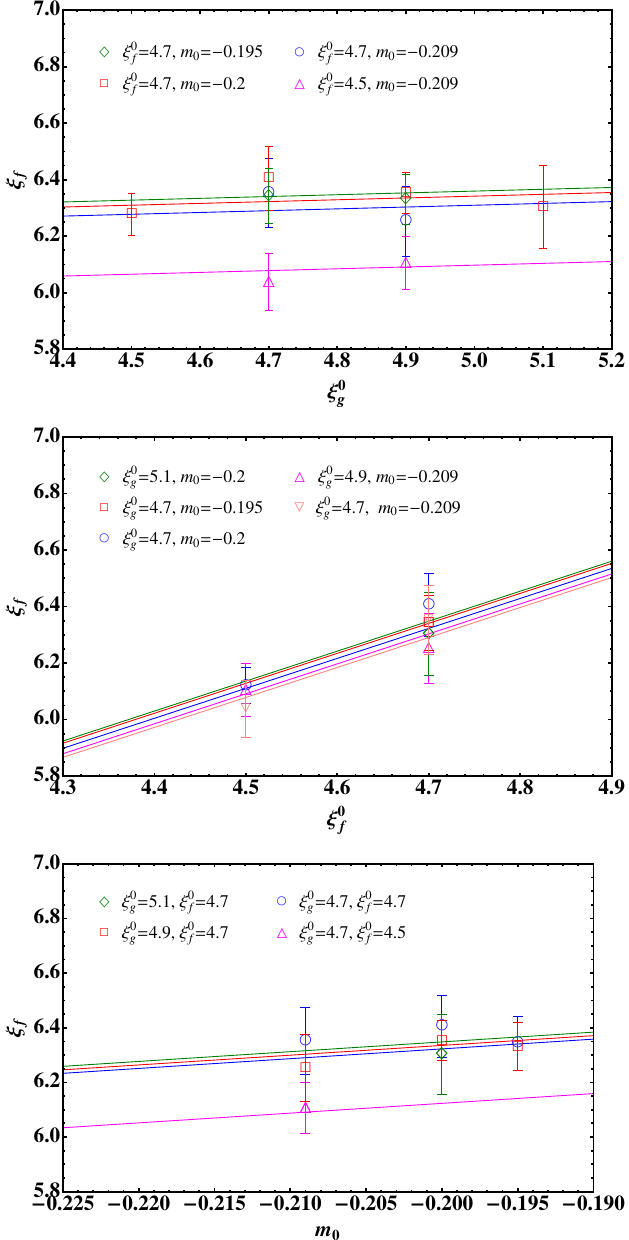
Figure 13 . Fermion anisotropy (cid:24) f as a function of (cid:24) 0 functions in eq. (3.7) where the coe(cid:14)cients are given by eq. (3.13).